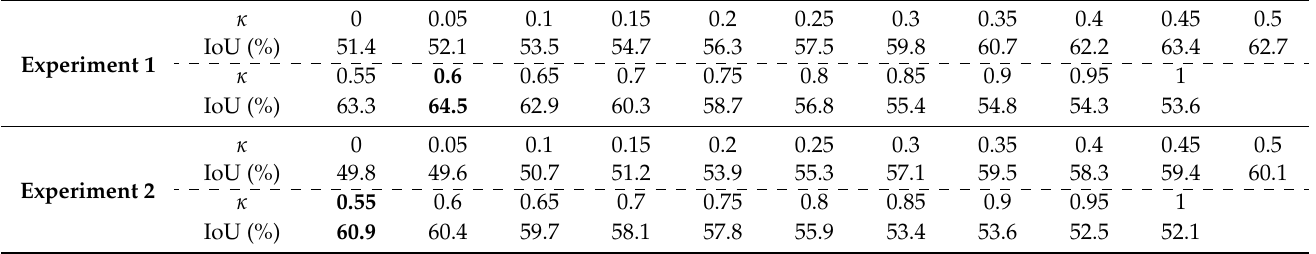
Figure 11. The relationship between similarity regulation indicator Table 4. Detailed κ − IoU values in the two experiments. The entries in bold denote the best results in the corresponding